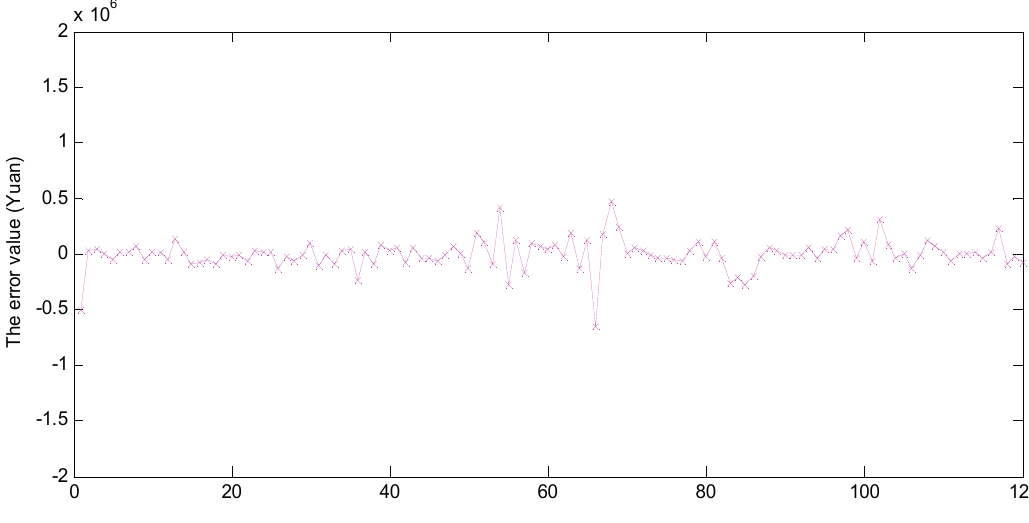
Figure 6. Error curve based on APAPSO-LMS